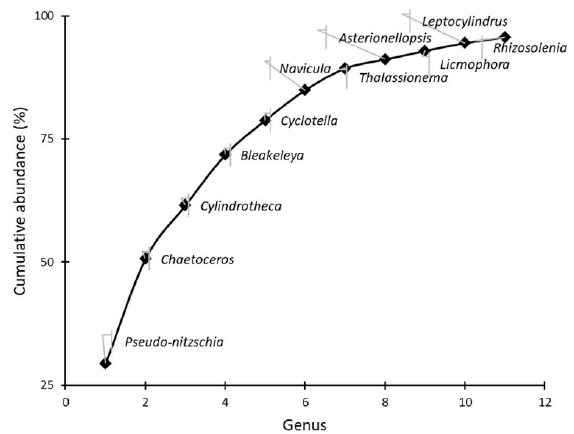
Figure 3. Average genus contribution to diatom abundance for 102 analysed samples. The 11 presented genera accounted for 95.7% of the total diatom abundance throughout the investigated period at Strmica